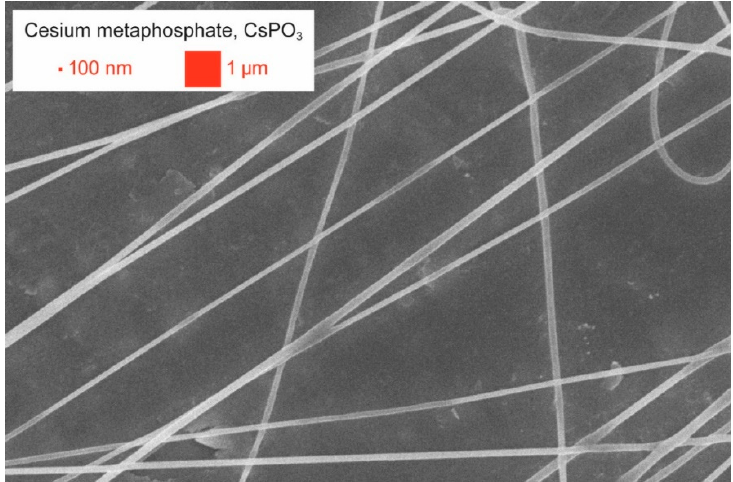
Figure B4. Cesium metaphosphate electrospun fibers produced from our device. Median diameter of fibers from this sample was 212 nm.